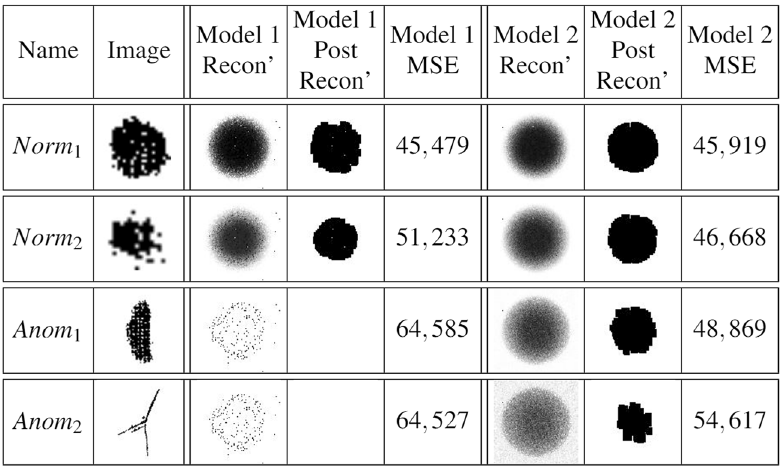
Table 1. Reconstruction of impurities in both